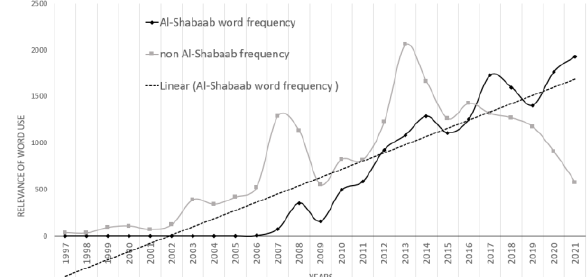
Figure 4. The absolute number of use of “Al-Shabaab” word by years.